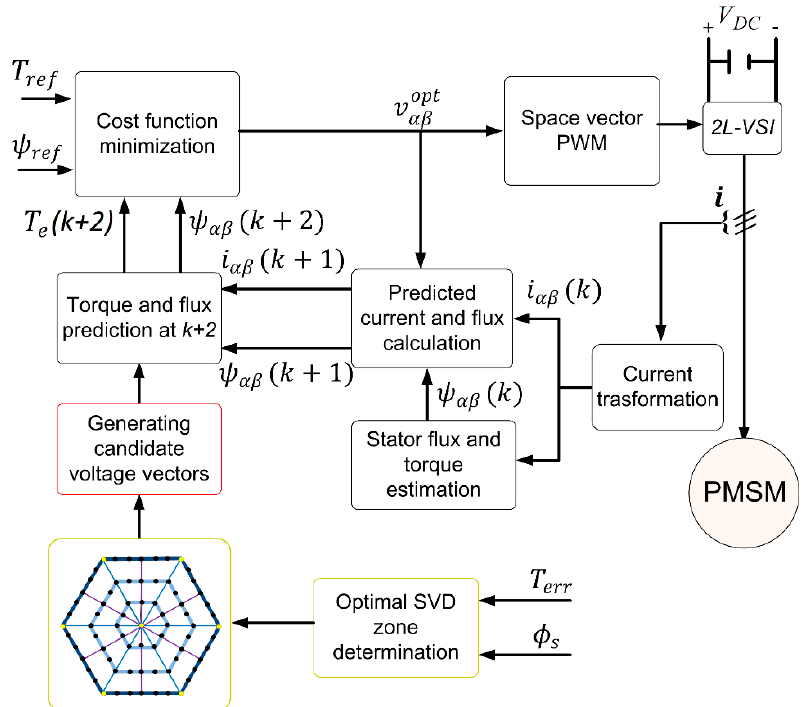
Figure 5. Proposed control block diagram for PTC-DSVM of the permanent magnet synchronous motor (PMSM).